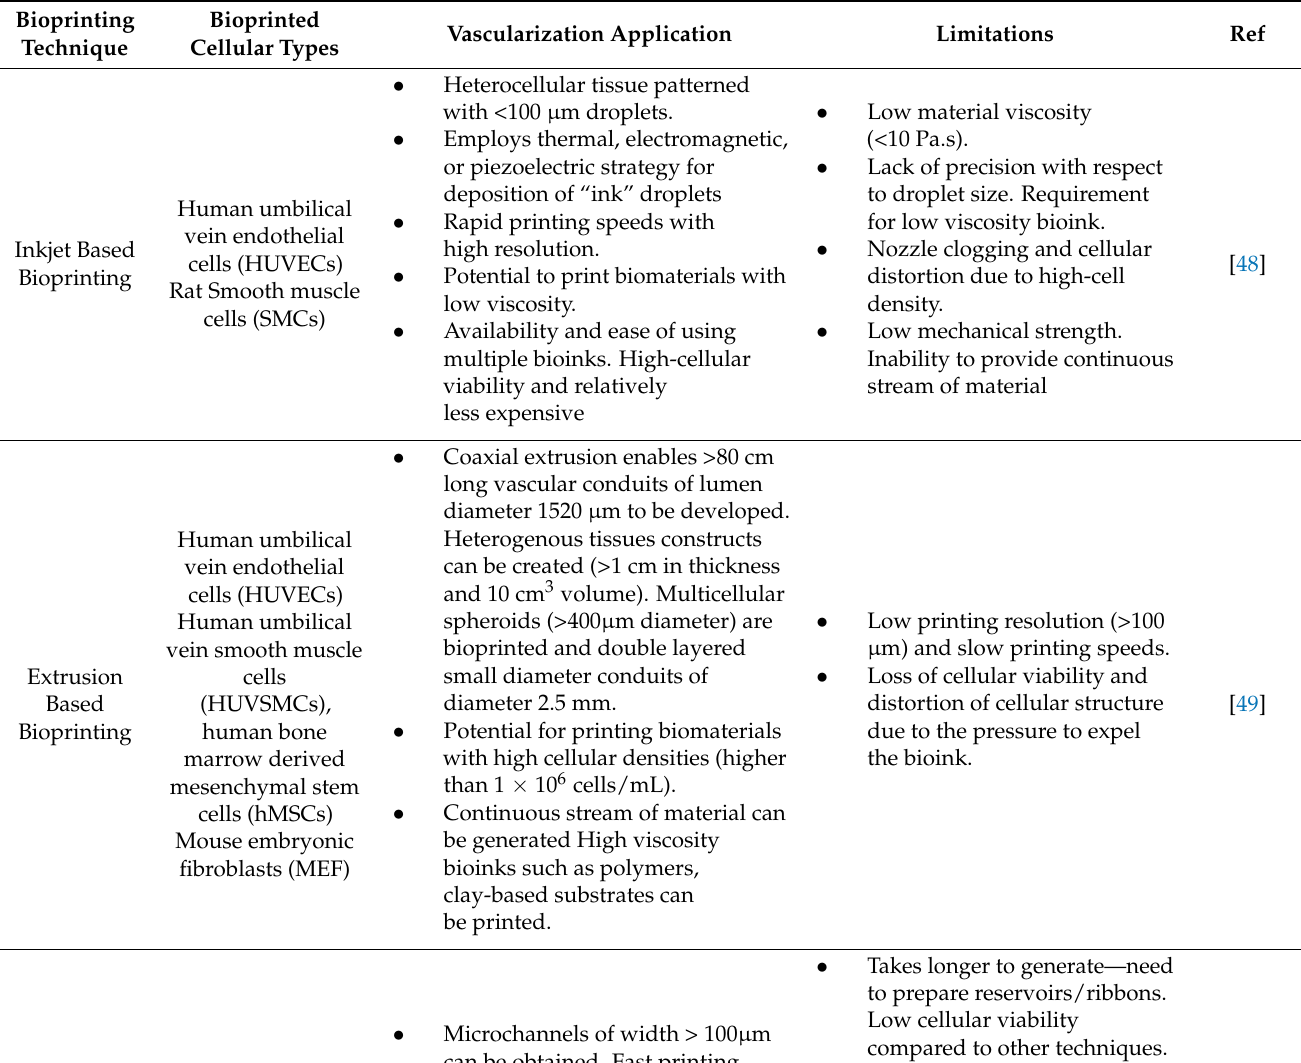
Table 2. Comparison of bioprinting methods for fabrication of vascularized engineered